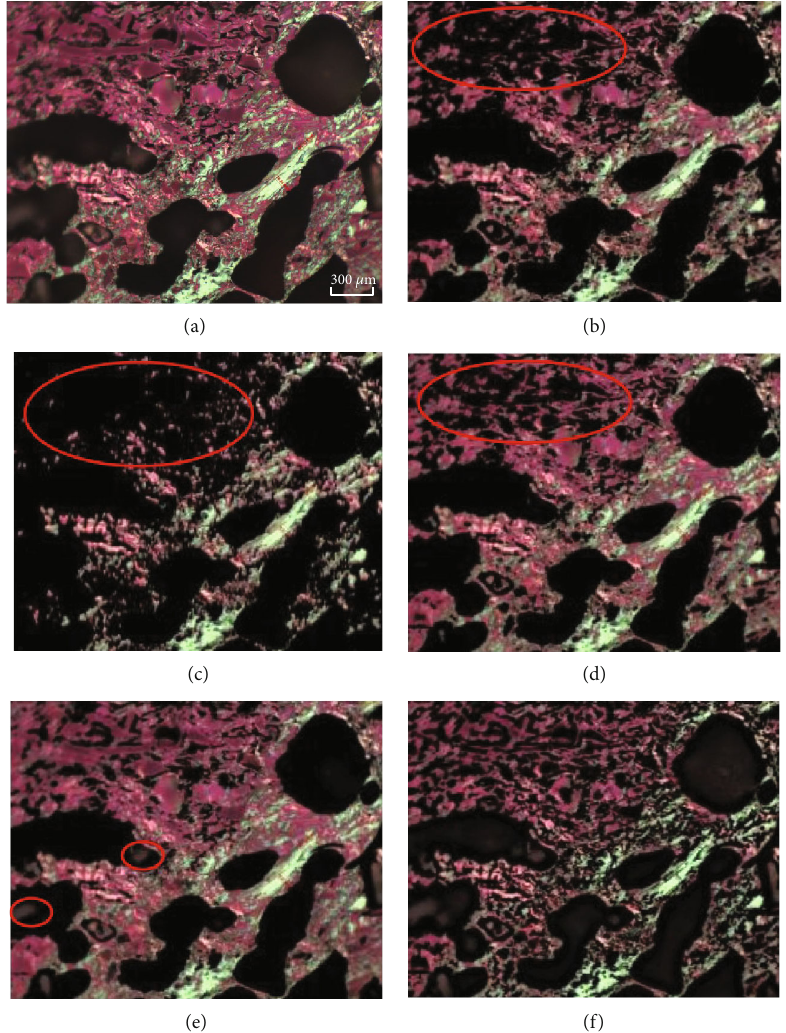
Figure 4: The segmentation e ff ect of several traditional algorithms in the main body: (a) original; (b) Otsu; (c) morphological; (d) watershed; (e) fi x threshold; (f) adaptive threshold.